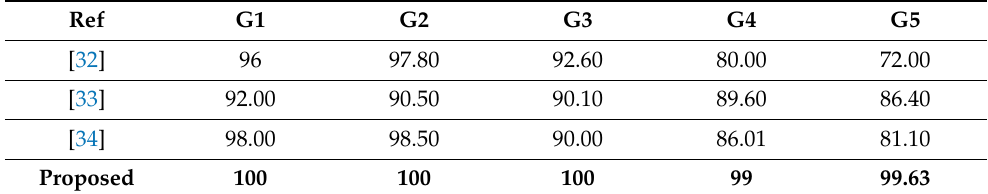
Table 3. Category-wise LP recognition accuracy comparison (%) on PKU